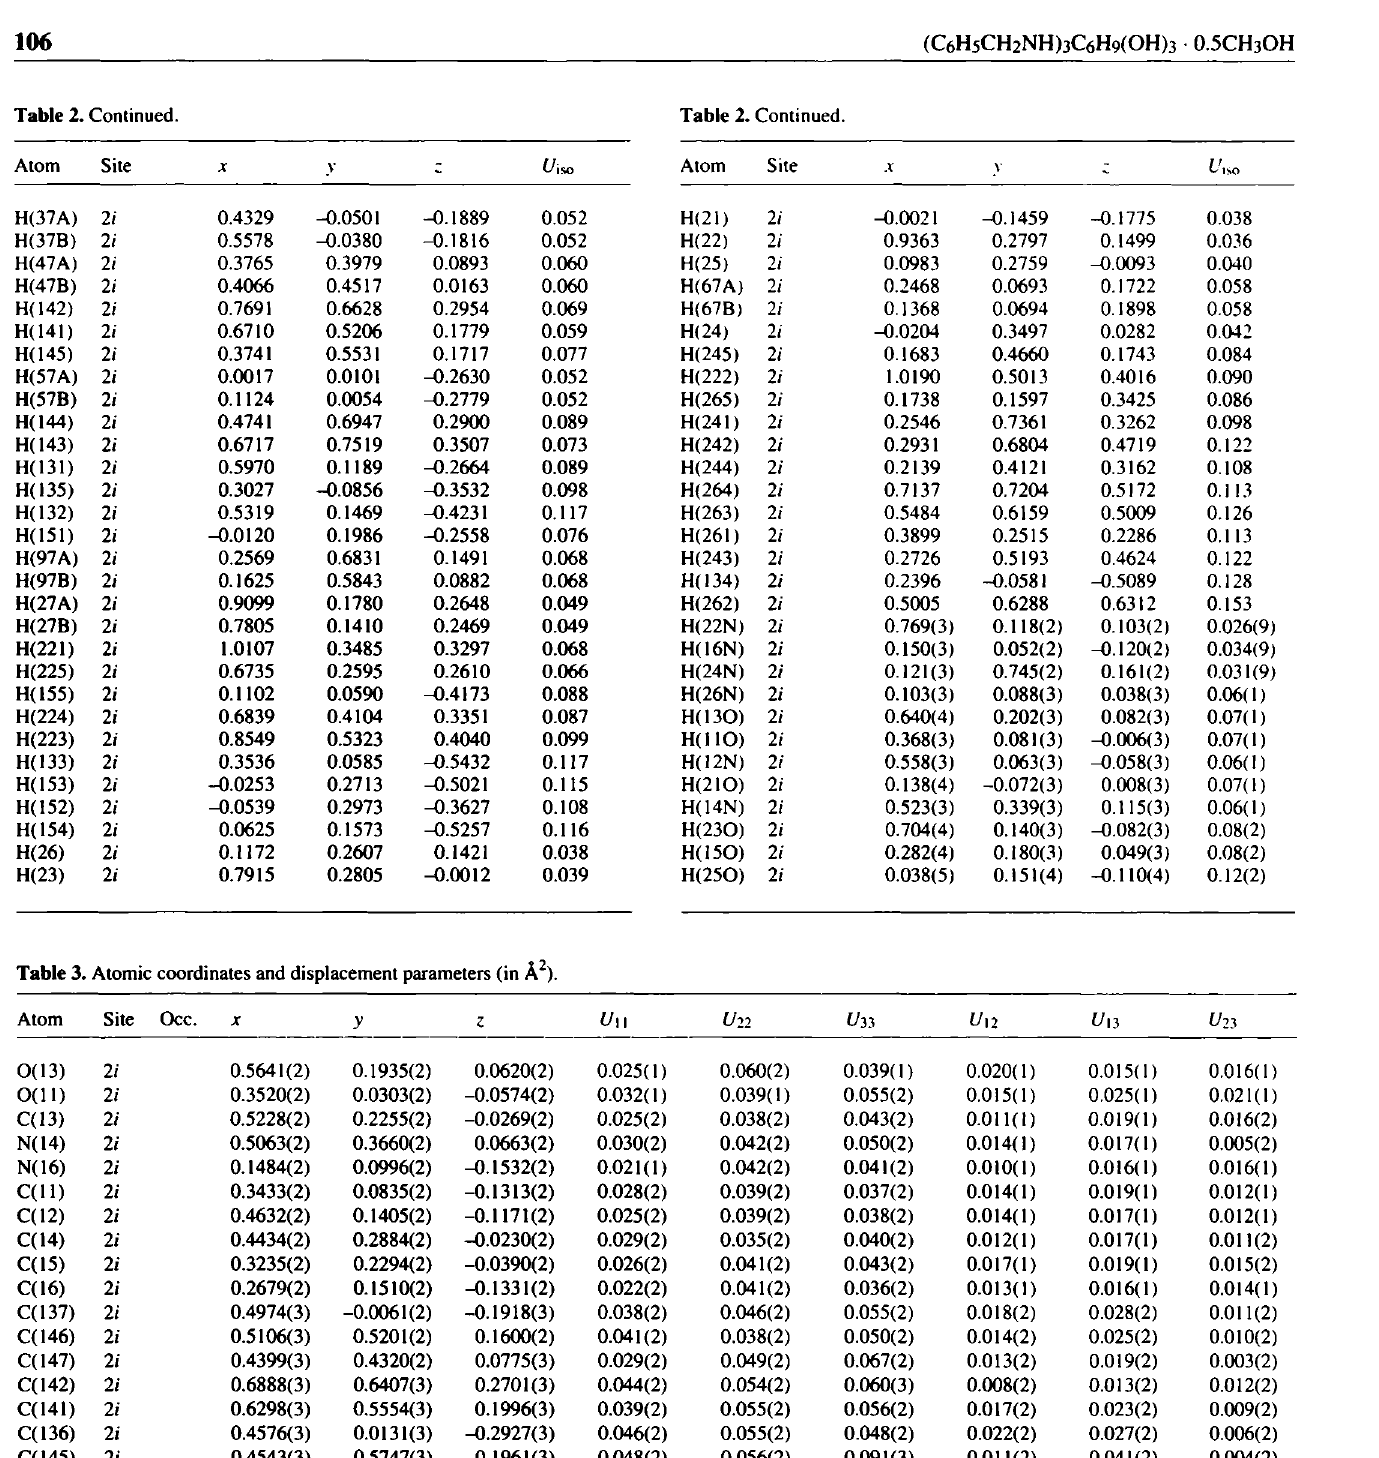
Table 3. Atomic coordinates and displacement parameters (in Ä 2